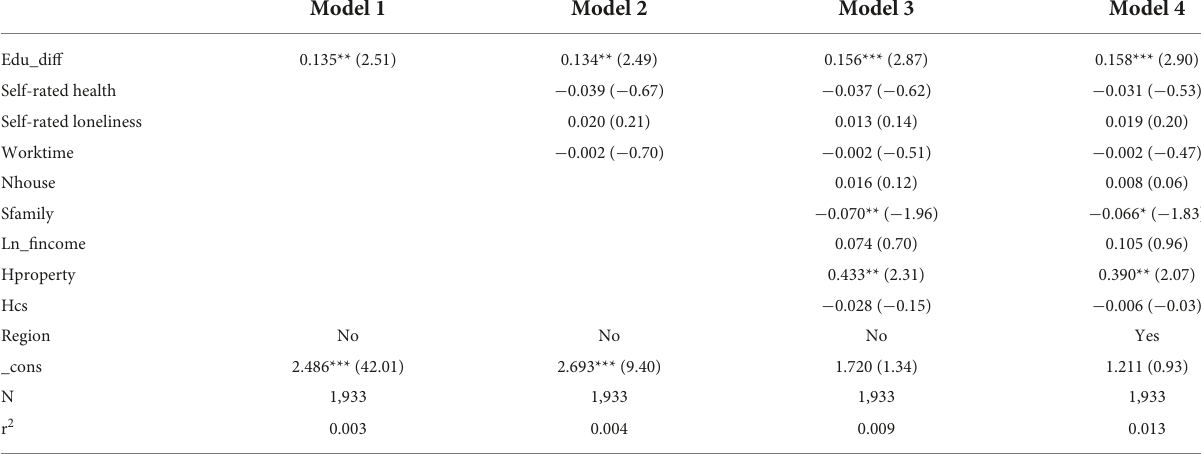
TABLE 3 Ordinary least squares (OLS) regression